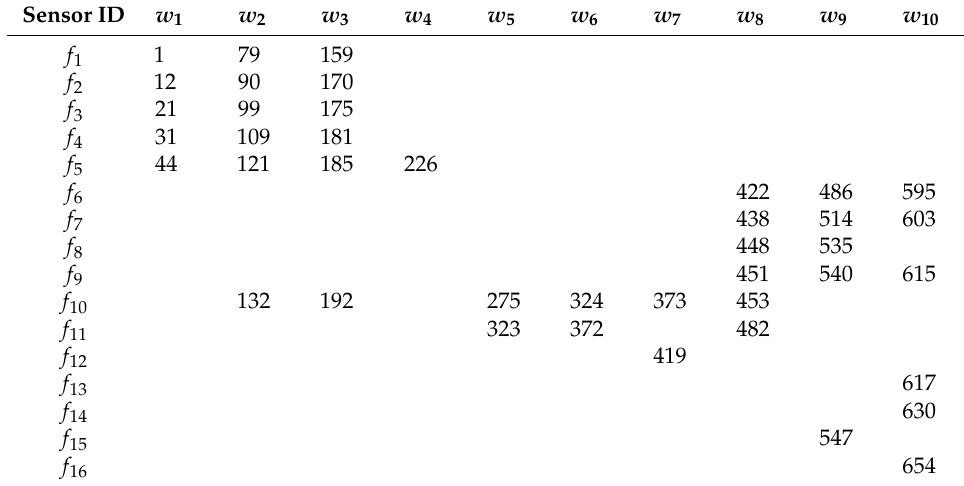
Table 3. The placement of the sensors is defined based on the activity IDs. As can be seen in the table, not all the f i i = 1, . . . ,16 fixtures are active at every w j j = 1, . . . ,10